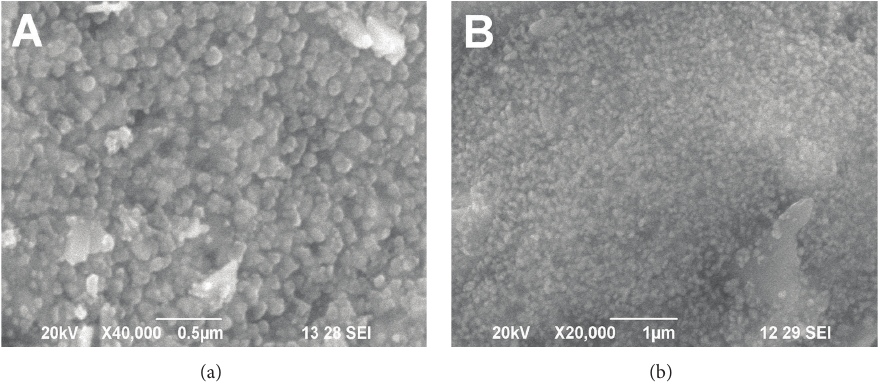
Figure 5: SEM images of P. nigrum leaf- (a) and stem- (b) synthesized silver